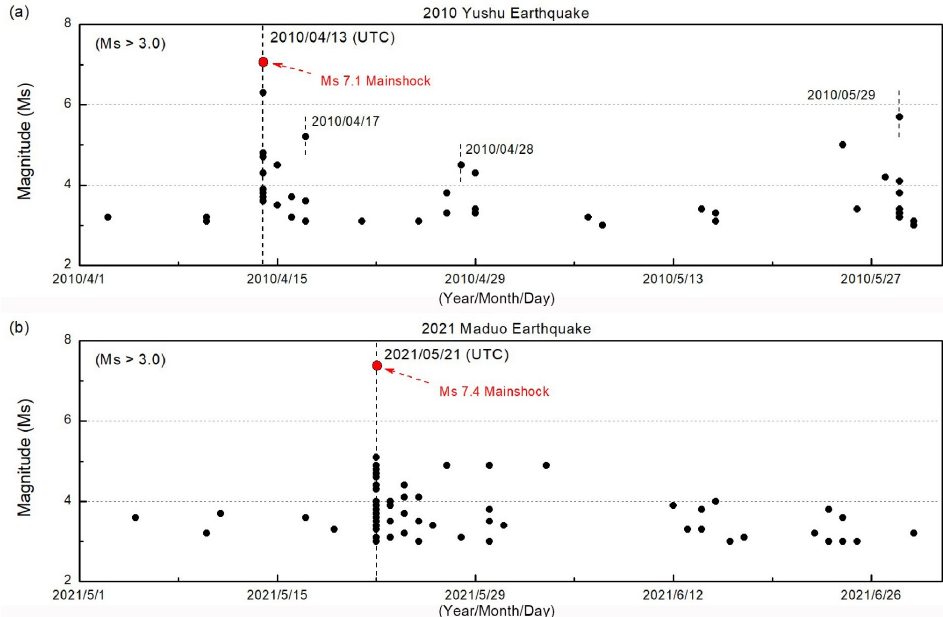
Figure 10. Diagrams of EQ frequency before, during, and after the 2010 Yushu EQ ( a ) and the 2021 Maduo EQ ( b ).